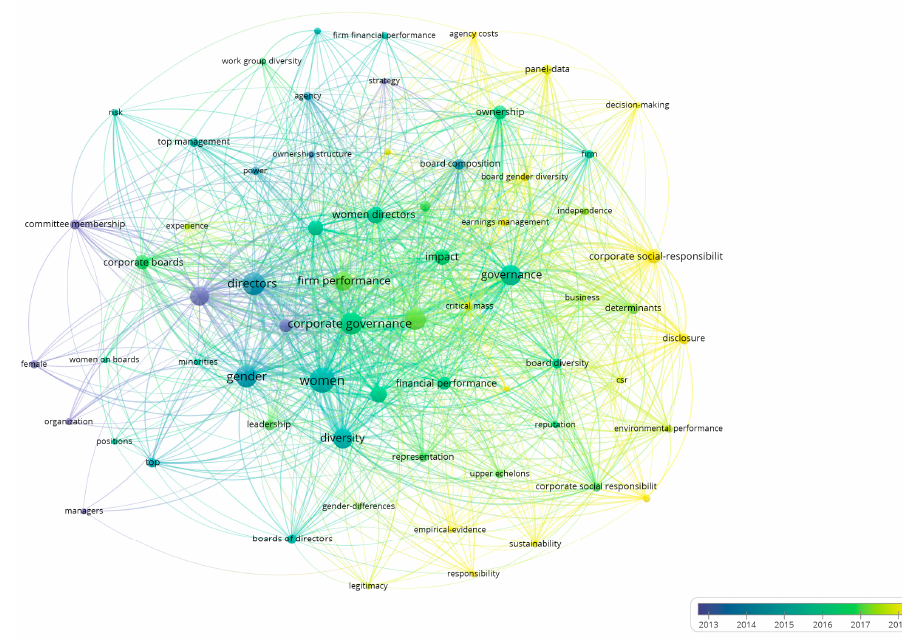
Figure 5. Evolution over the years 2013 to 2018 of the bibliometric keyword map.